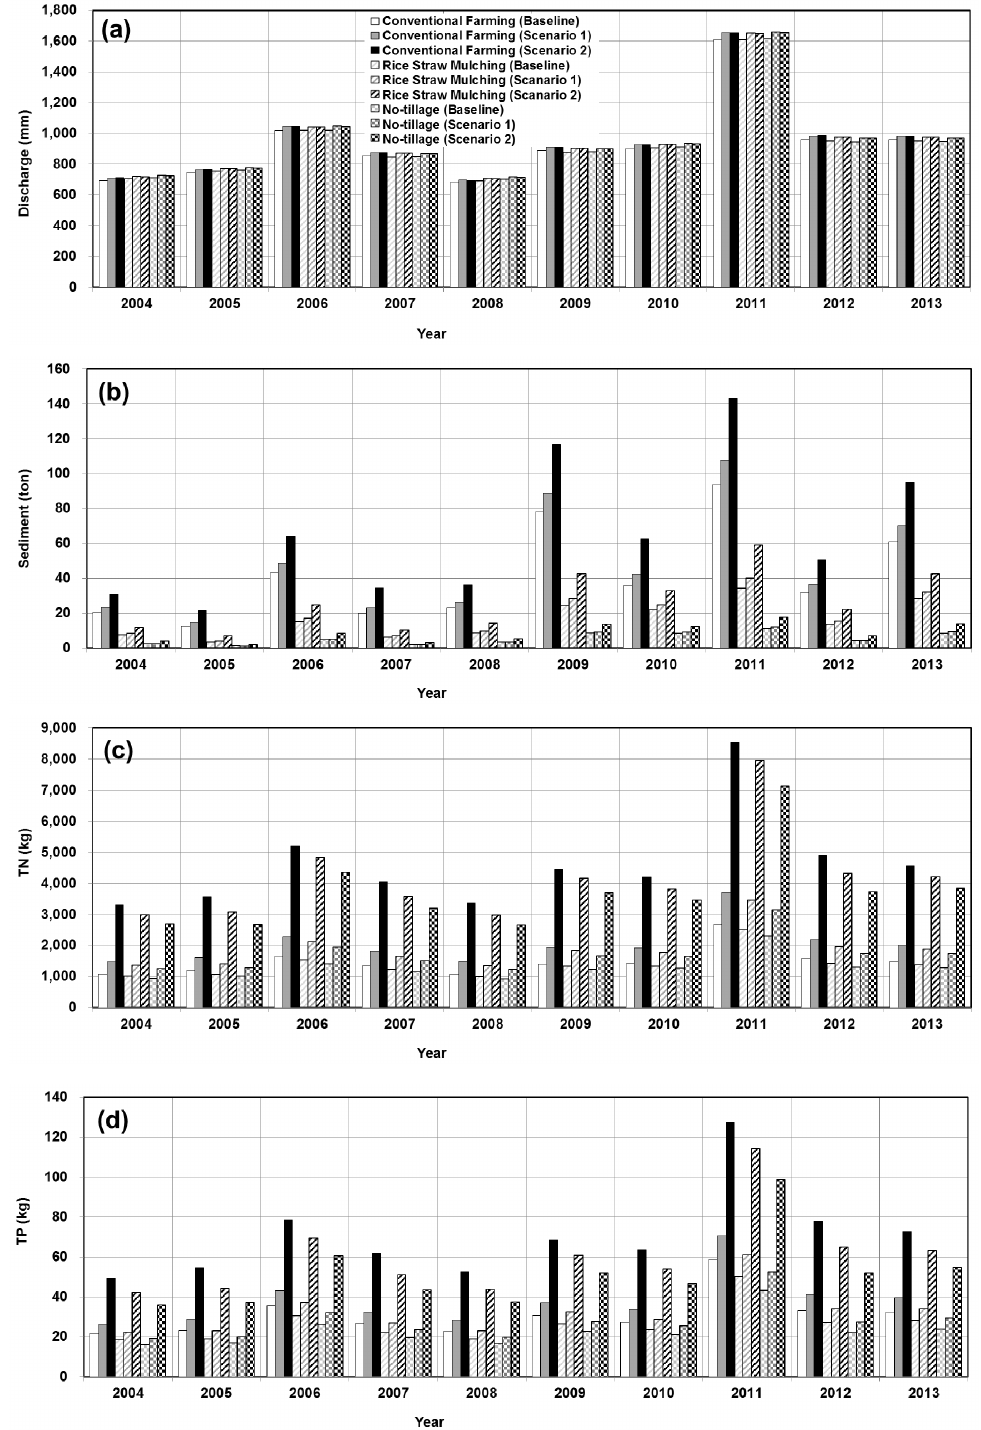
Figure 8. Annual change in the hourly simulated ( a ) discharge, ( b ) sediment, ( c ) T-N, and ( d ) T-P for conventional, rice straw mulching and no-tillage operations when applying change scenarios of upland crop areas